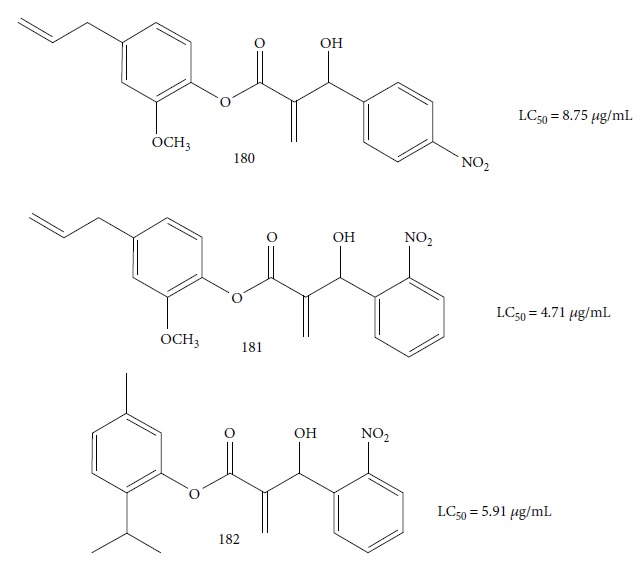
MBHA hybrids from eugenol, thymol, and carvacrol, chemical structures and IC50 values of the most potent derivatives against of L. amazonensis promastigote form.